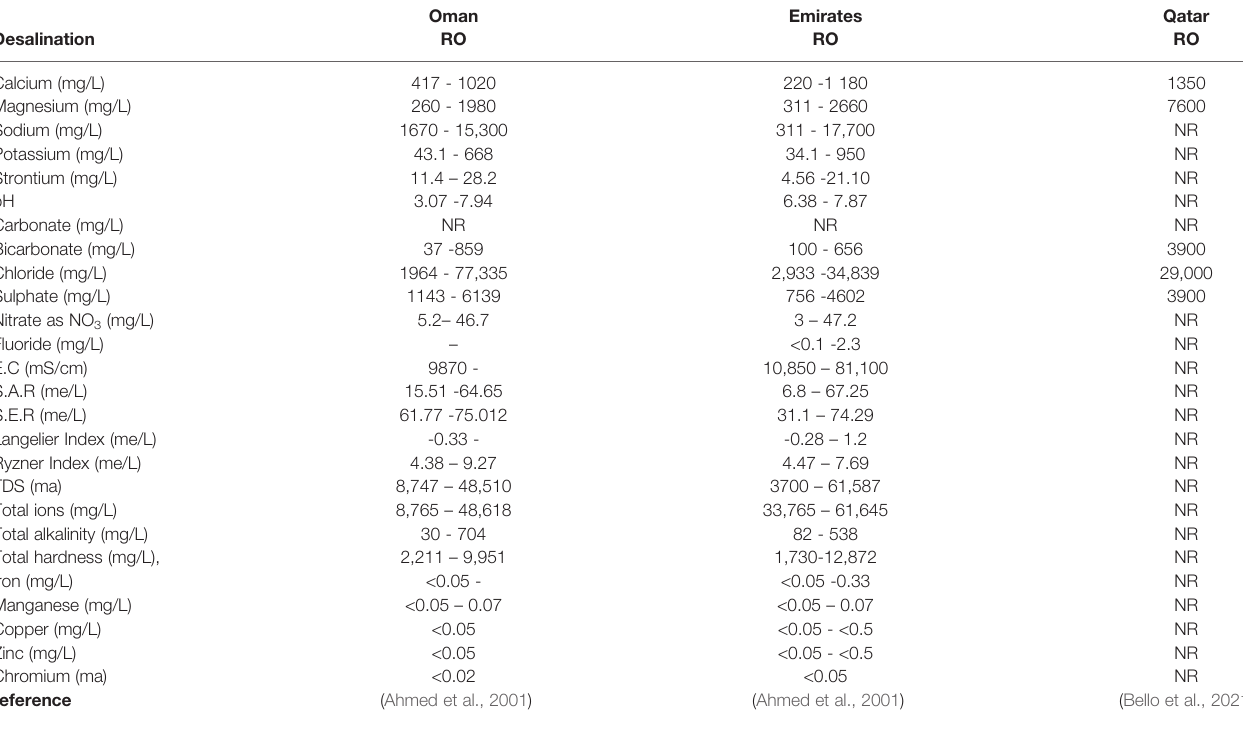
TABLE 1 | Physicochemical composition of the desalination brine.